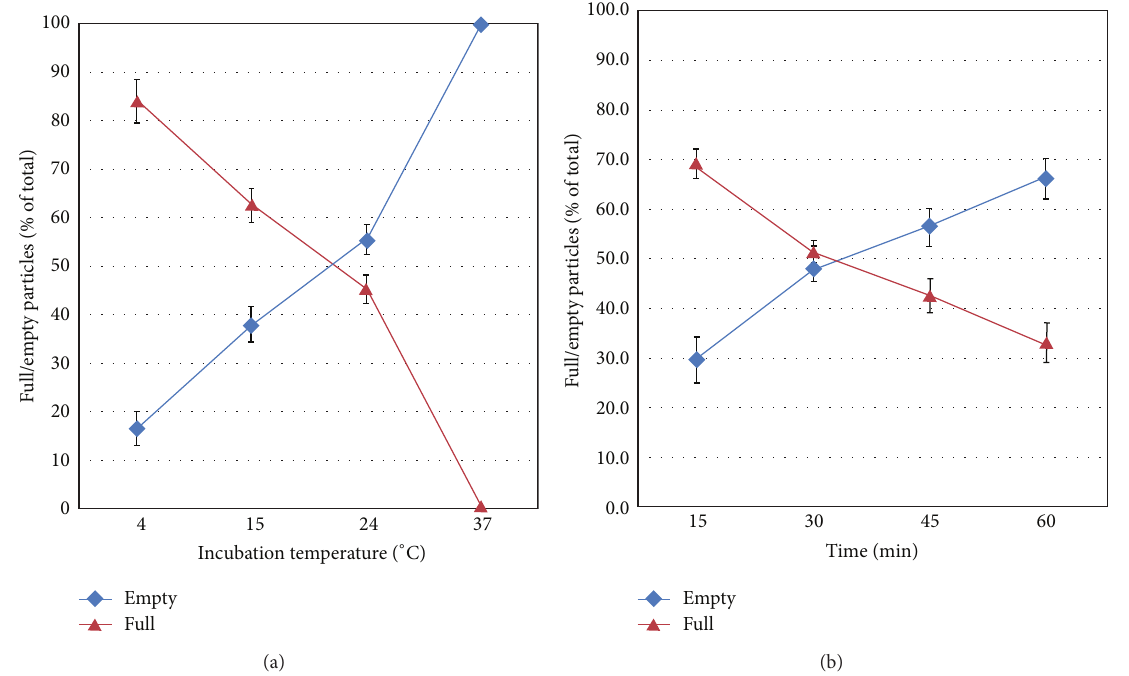
(a) Figure 12: Temperature and time dependence of Sindbis virus genome delivery into BHK cells. (a) Sindbis virus-cell complexes incubated and fixed at 15min postinfection at several temperatures were analyzed by electron microscopy. The graph shows that, as temperature rises from 4 ∘ C to 37 ∘ C, there is a progressive increase in the population of empty particles at the cell surface ( X ), representing the total population at 37 ∘ C, and a decrease in the population of full particles ( 󳵳 ), reaching zero at 37 ∘ C. (b) Interaction of Sindbis virus with BHK cells at 4 ∘ C for 15 to 60 min. The percentage of empty particles increases from 30% at 15 min to 66.6% at 60 min ( X ), and the population of full particles decreases from 70% to 33.4% over the same time period ( 󳵳 ). Data are shown as the means of triplicate samples of two independent experiments. Error bars are standard errors of the means (SEM). From Vancini et al. 2013